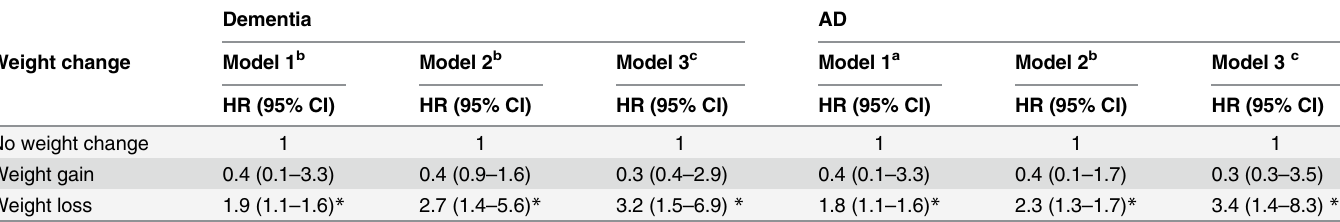
Table 2. Relative risk of progression from MCI to dementia and Alzheimer's disease in relation to weight change: Cox regression model adjusted for the potential confounding variables in 102 subjects.